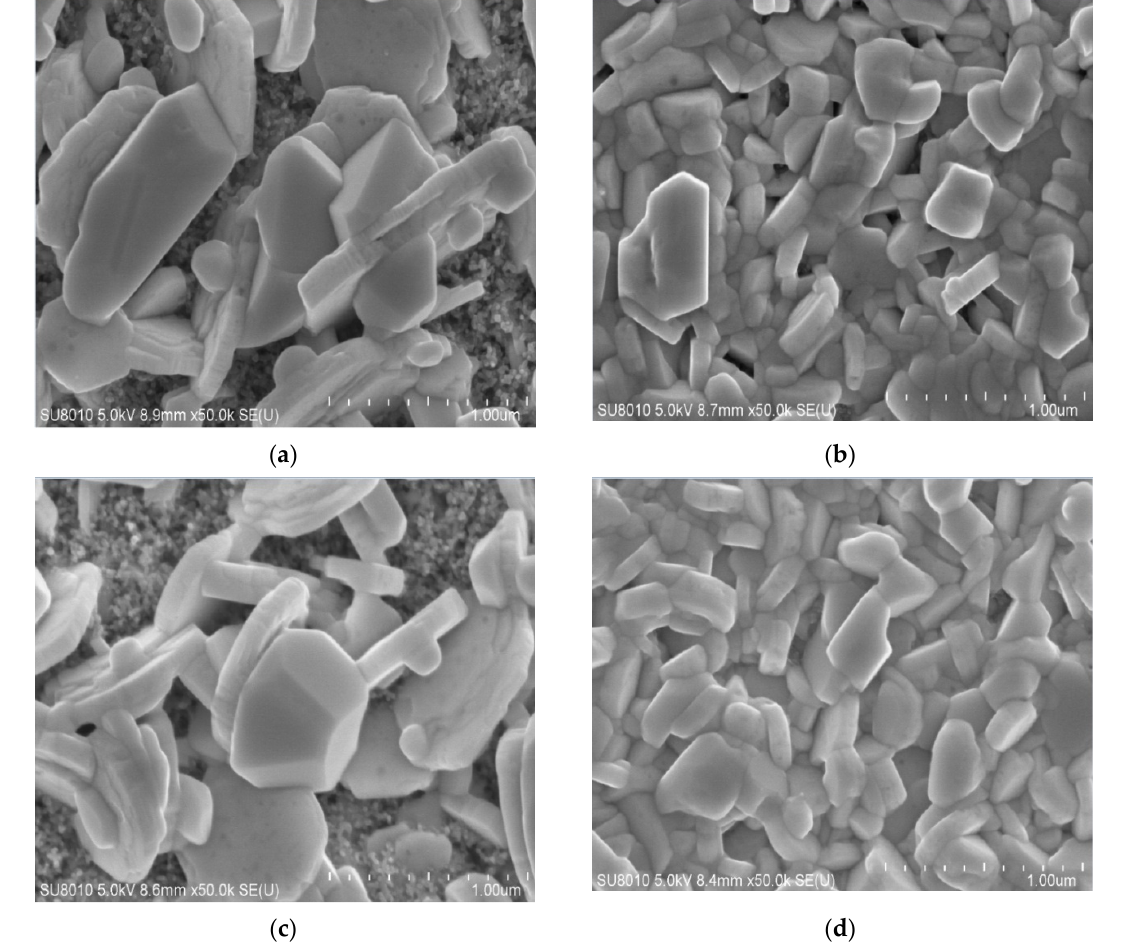
Figure 2. SEM images for the films annealed: ( a ) with DMF only; ( b ) with the mixture of DMF and DMSO; ( c ) with DMF only under DMF/CH 3 0H solvent vapour annealing; and ( d ) with DMF and DMSO under DMF/CH 3 0H solvent annealing.